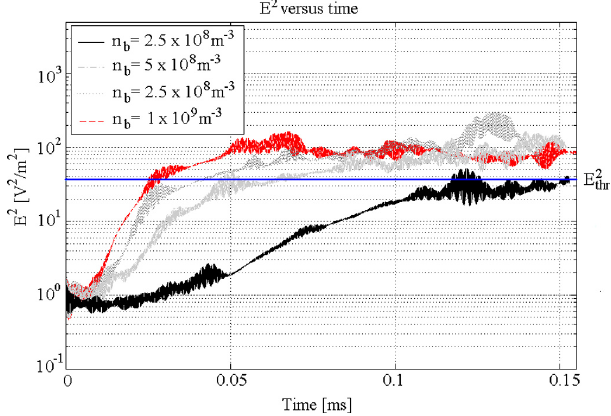
Fig. 4. Magnitude squared electric field versus time for simulations with parameters presented in Sect. 3.1 for the four beam